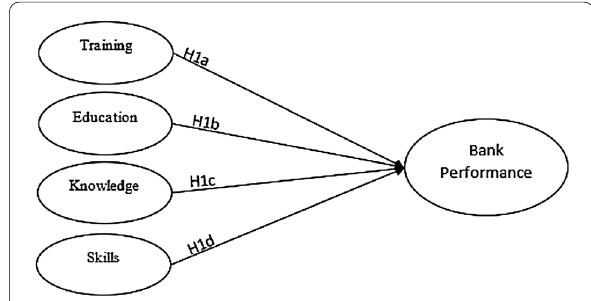
Fig. 1 Conceptual model of the research